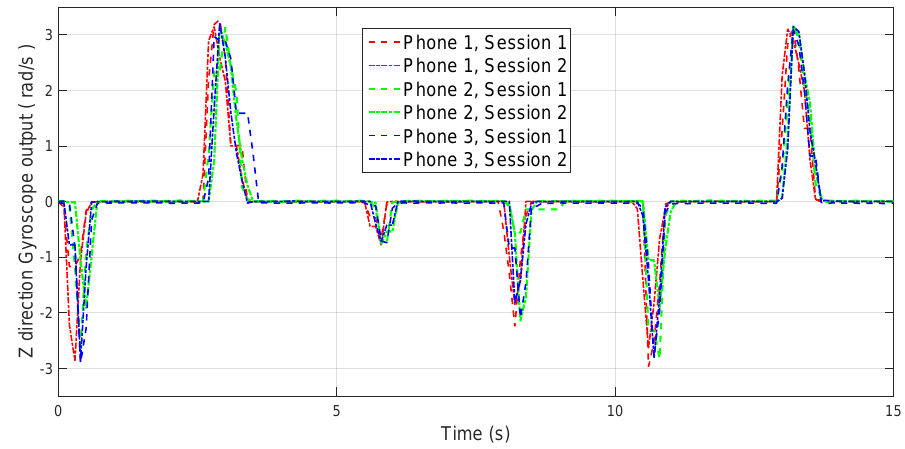
Figure 3. z -output from the Gyroscopes as received from the normal axis to the frontal plane of the